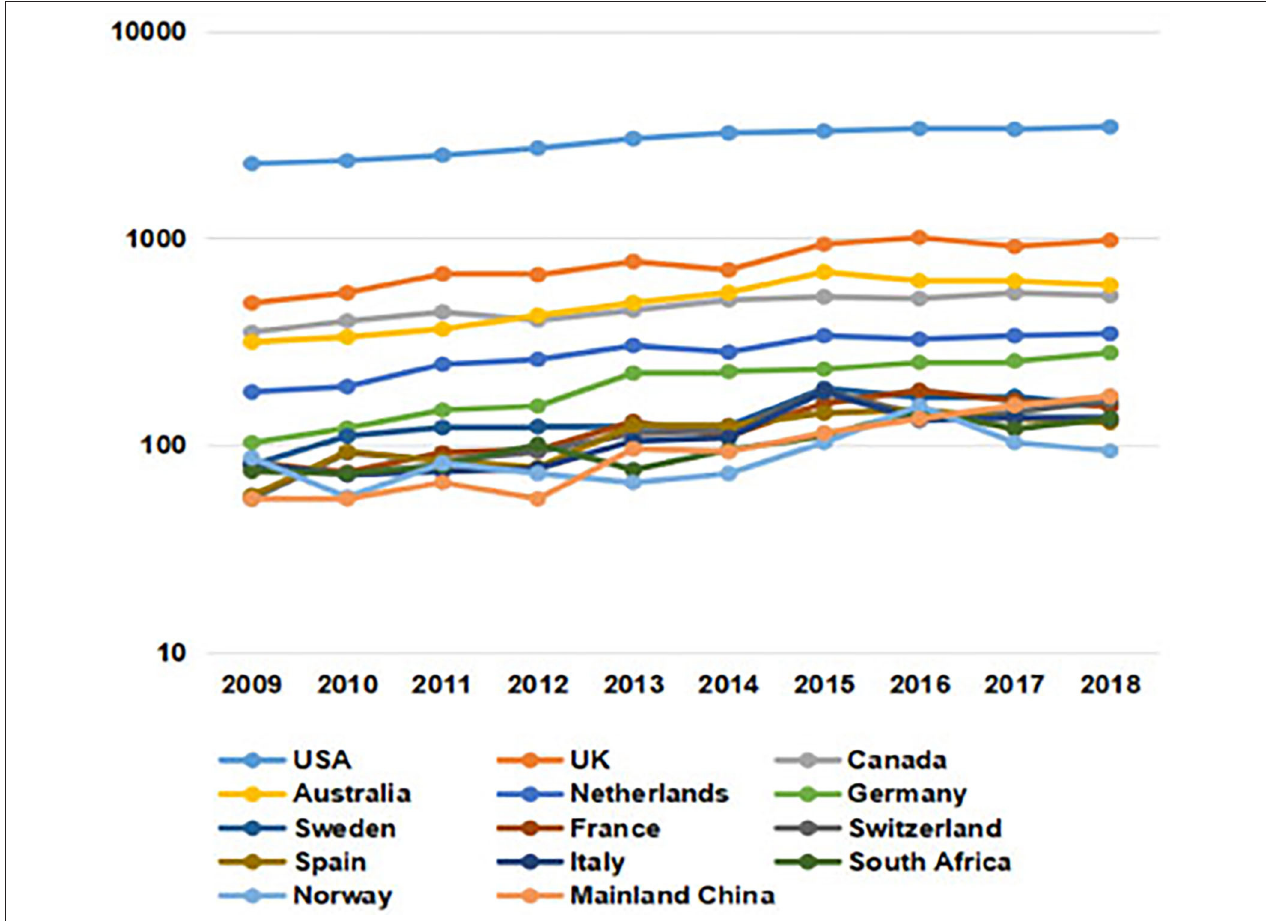
FIGURE 2 | Number of papers of health policy and services from 2009 to 2018 by